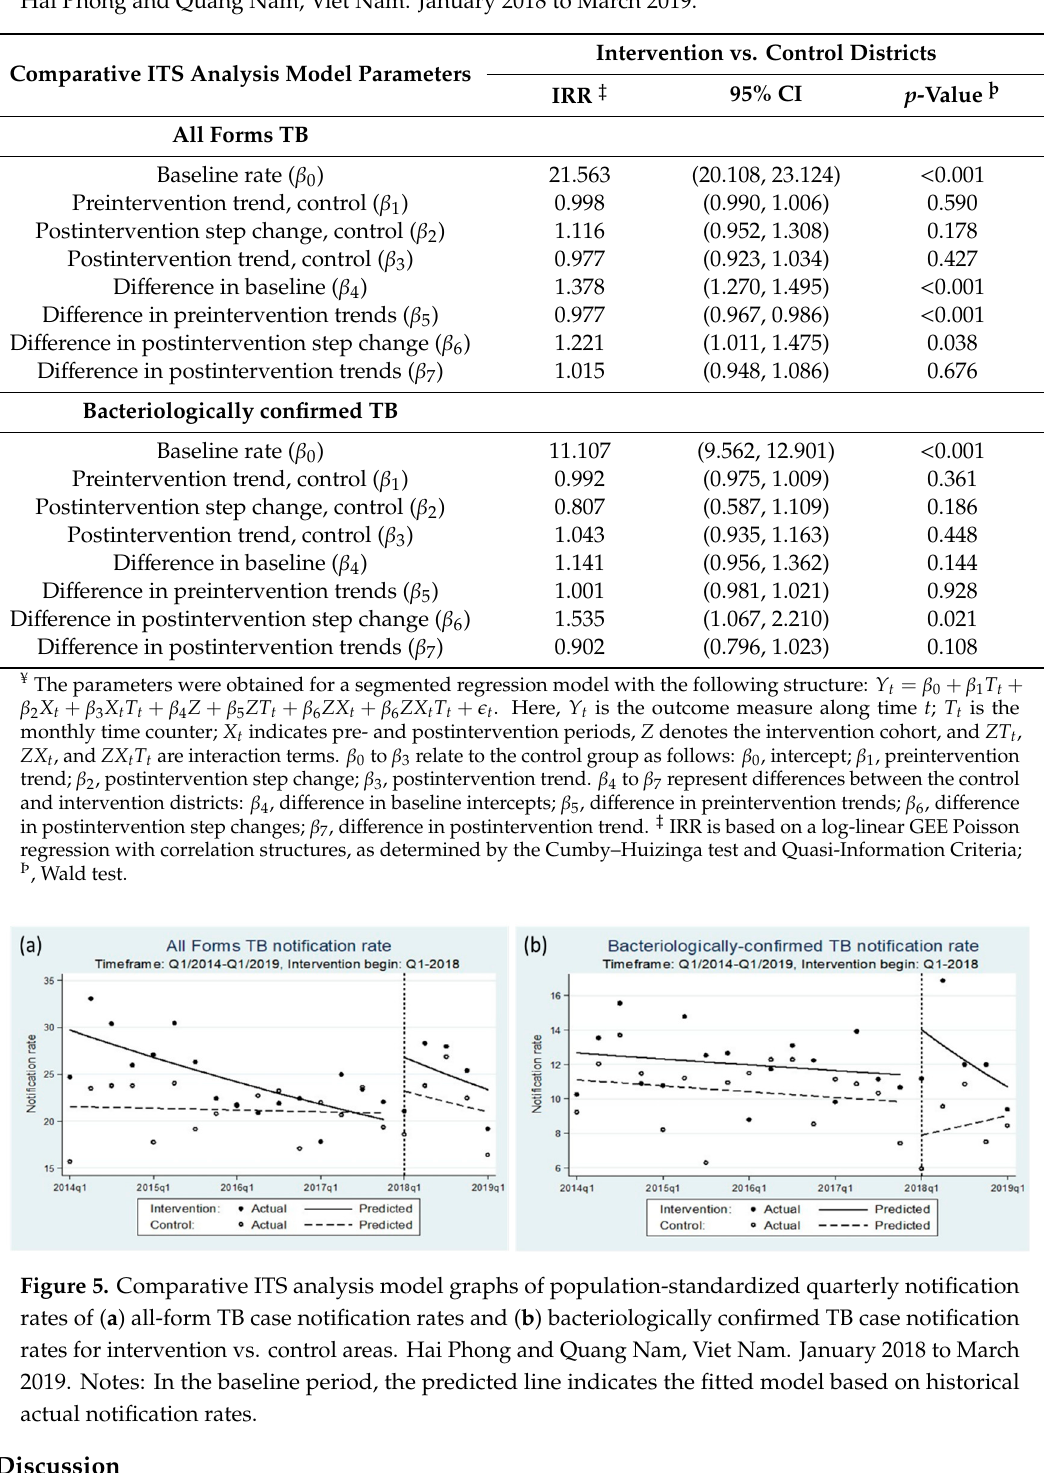
Table 4. Comparative ITS analysis model parameters of population-standardized quarterly notification rates of all-form and bacteriologically confirmed TB cases for intervention vs. control districts ¥ .